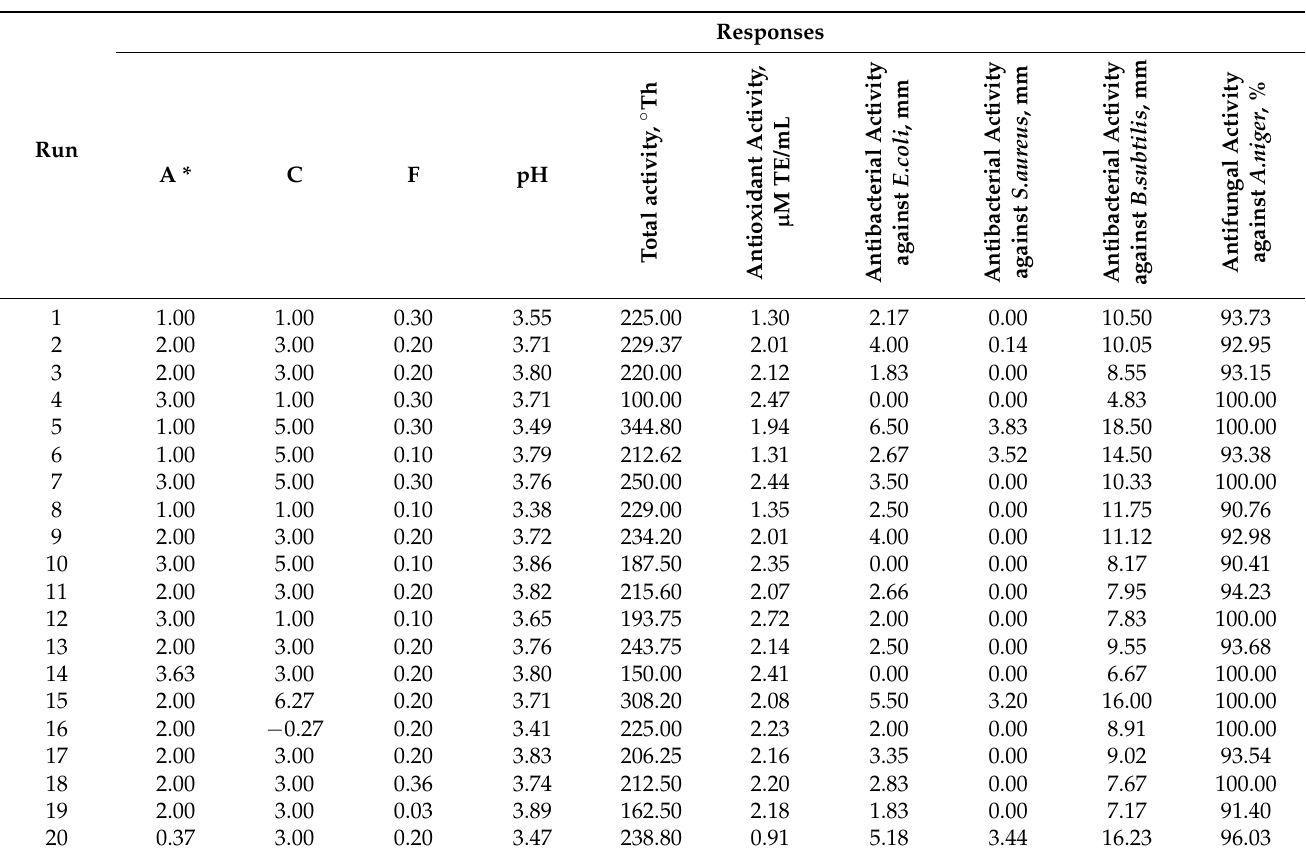
Table 5. CCD and the analyzed responses in correlation with the independent variables